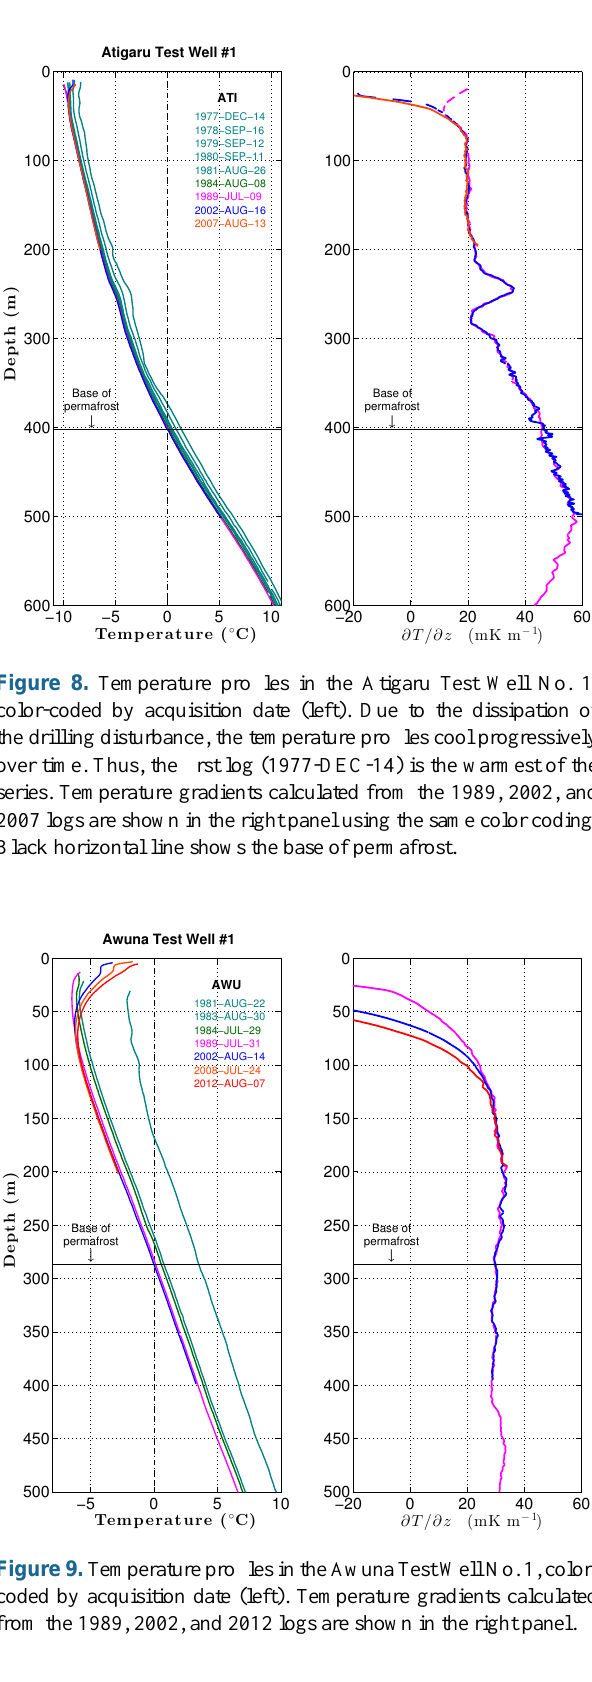
Figure 5. Layout of the post-1999 version of the USGS portable temperature logging system used in arctic Alaska.